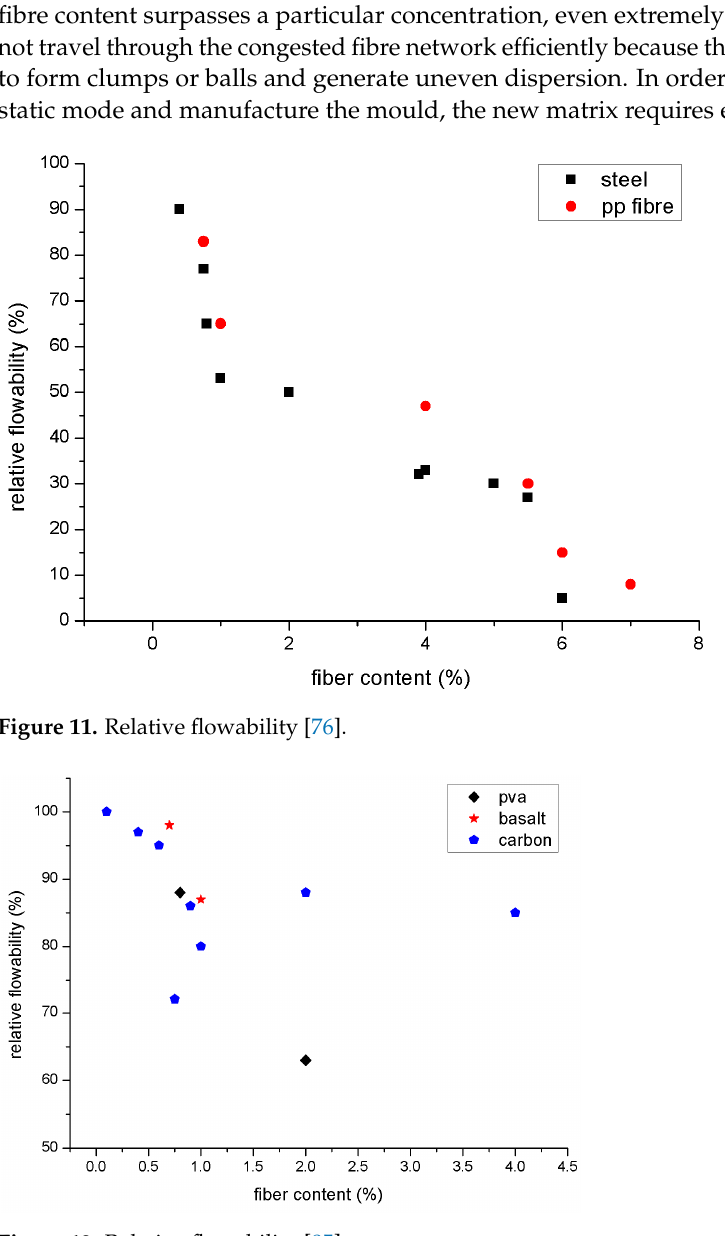
Figure 12. Relative flowability [85].